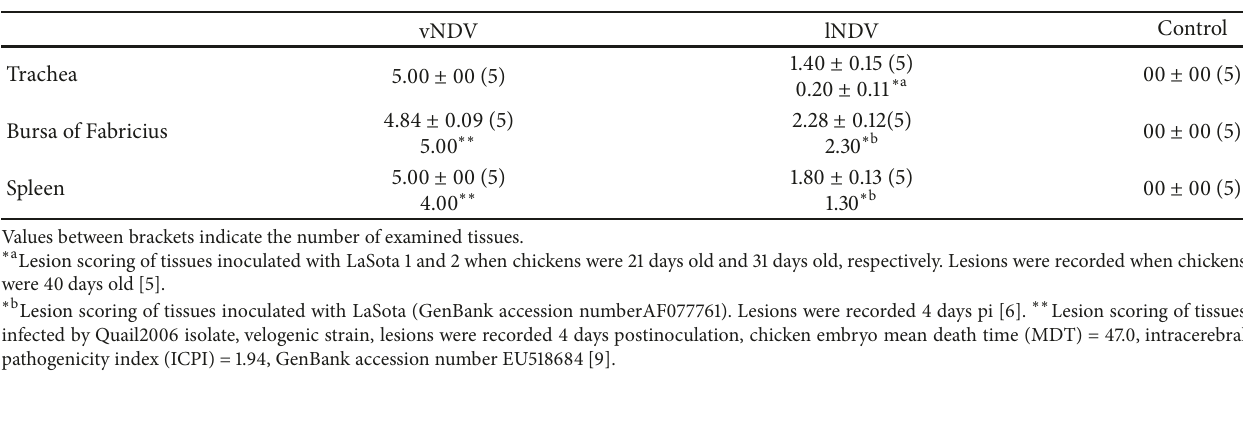
Table 9: Lesions scoring (0-5) induced by velogenic and lentogenic NDV strains in HE stained trachea, bursa of Fabricius, and spleen tissues on day 5